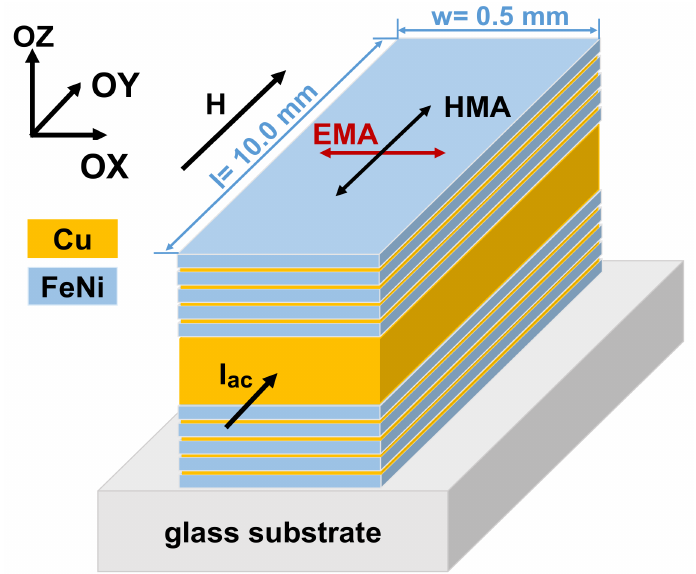
Figure 1. Scheme of multilayered [FeNi (100 nm)/Cu (3 nm)] 5 /Cu (500 nm)/[Cu (3 nm)/[FeNi (100 nm)] 5 MI sensitive element. EMA—easy magnetization axis; HMA—hard magnetization axis; I ac —high frequency alternating current flowing along the rectangular MI element; H—external